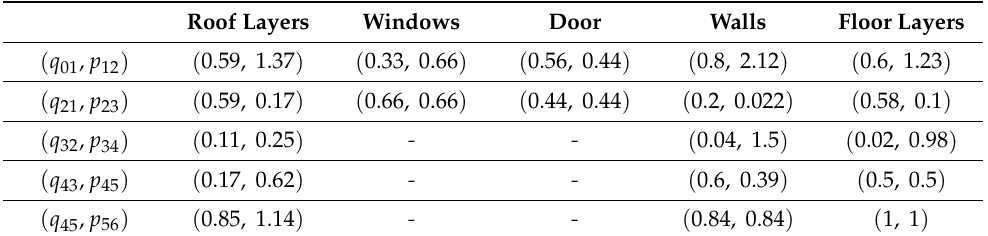
Table 1. The r(q,p) set of state parameters for the model.